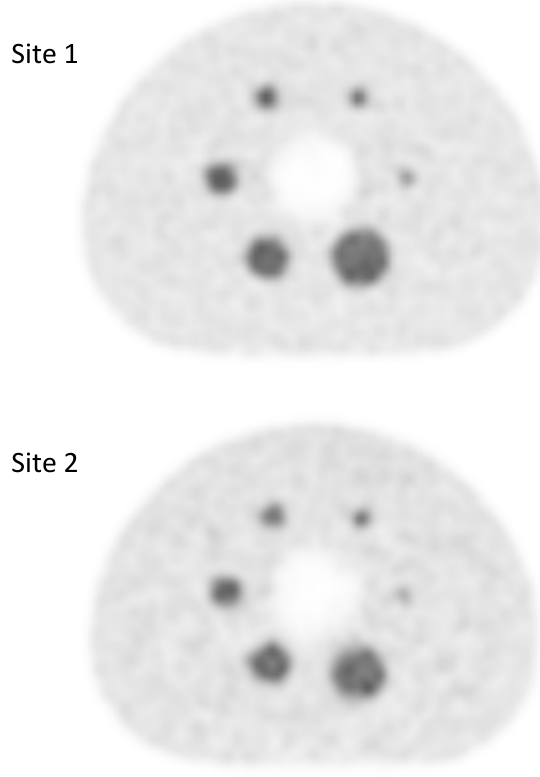
Figure 3. Qualitative assessment of FDG PET images obtained at site 1 (GE Discovery 690 PET scanner) and at site 2 (Siemens Biograph mCT 64 PET scanner).